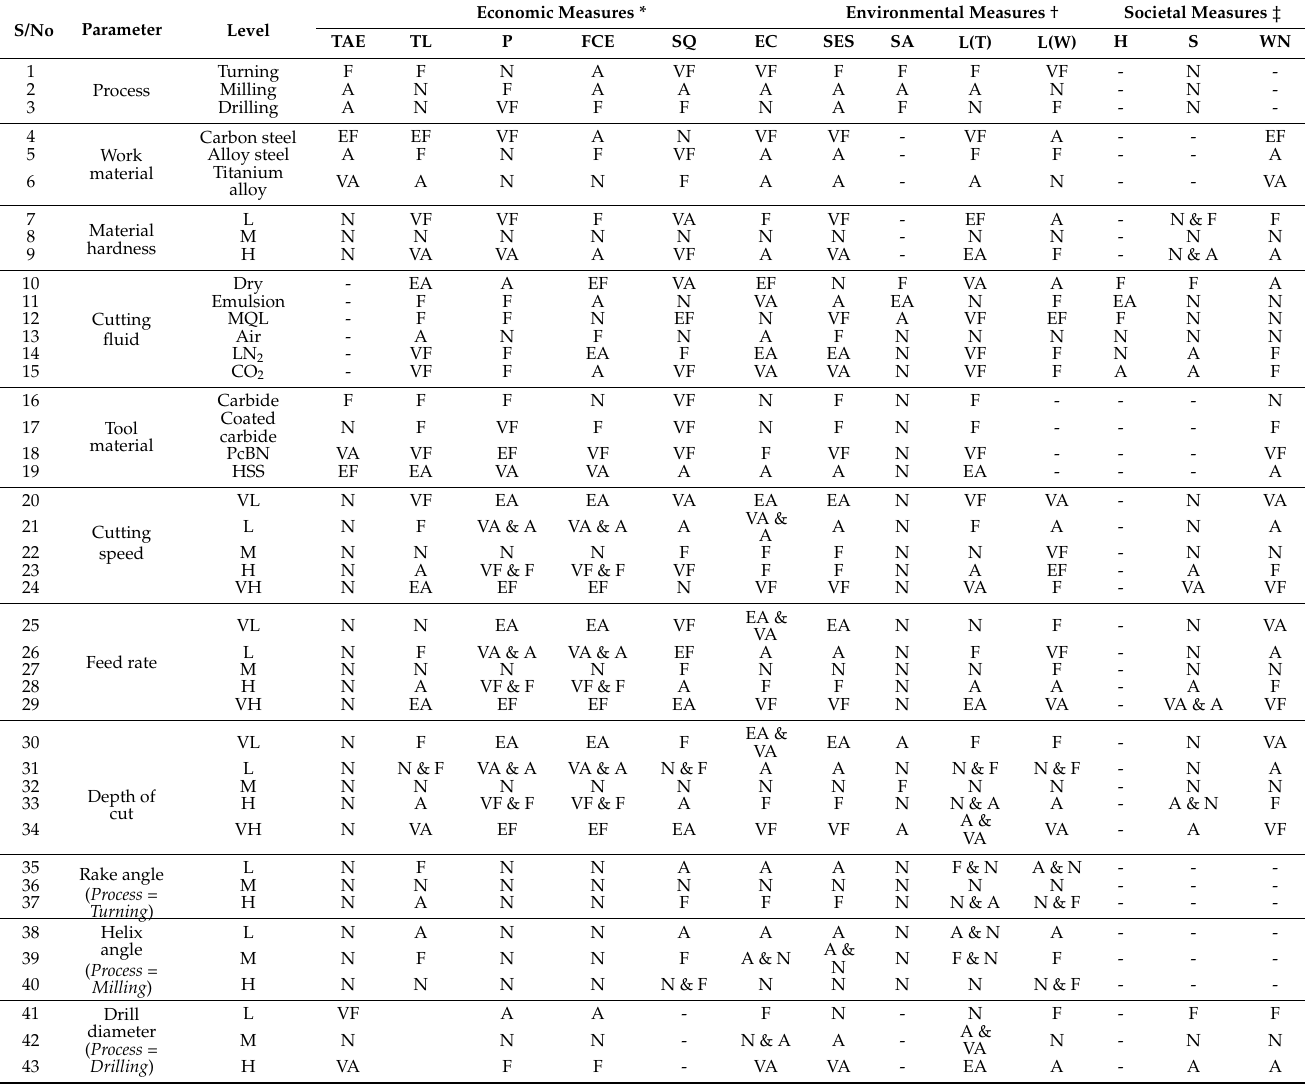
Table 2. The Fuzzy Rule-Base for the Estimation of Machining